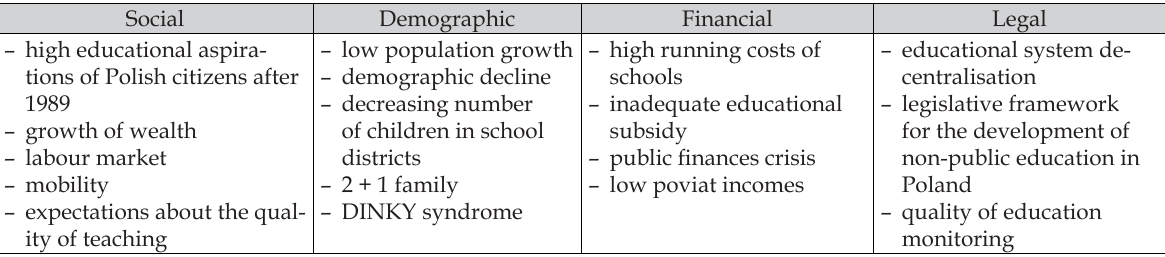
Table 1. Selected determinants of the educational services market in